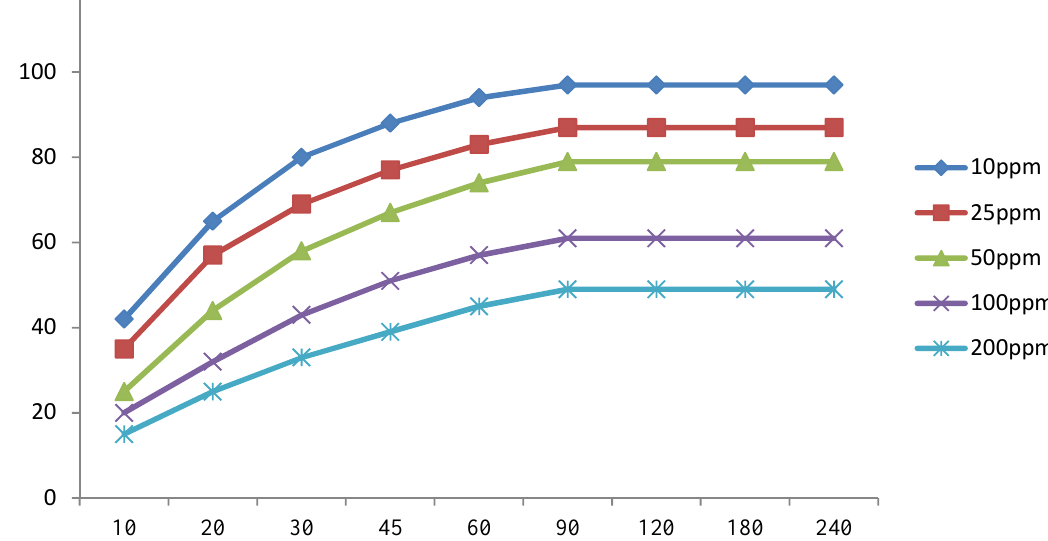
Figure 2. Effect of contact time and initial dye concentration on removal efficiency (pH = 3, adsorbent dosage 1 gr/100